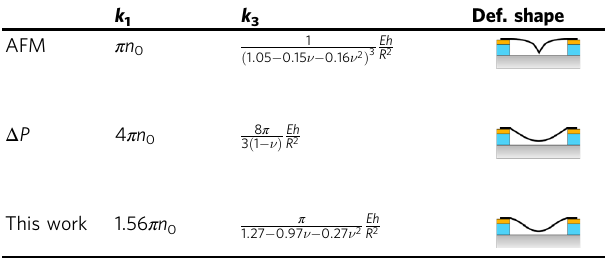
Table 1 Values for k 1 and k 3 for different deformation shapes k k 1 3 Def. shape